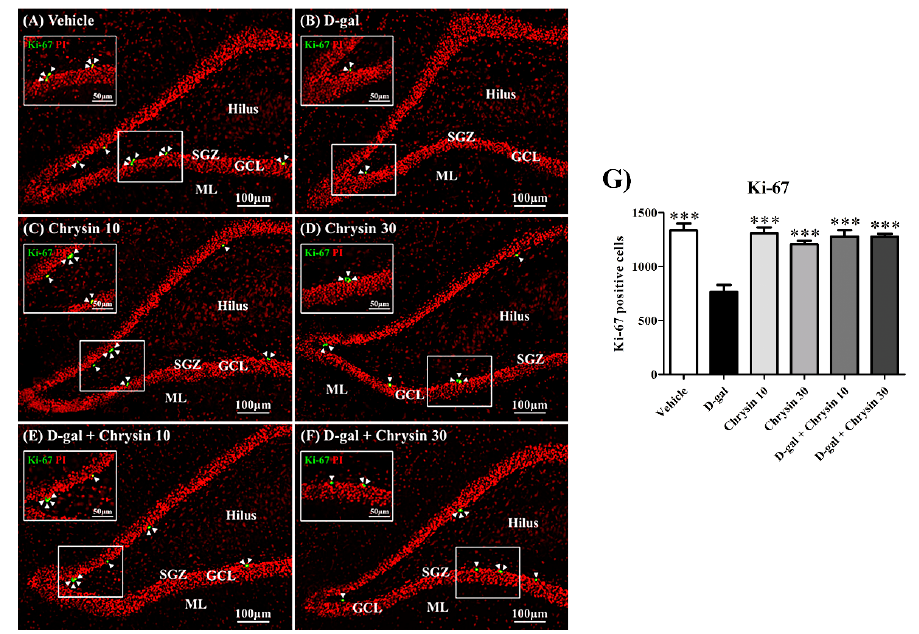
Figure 5. Immunofluorescence staining of all the experimental groups ( A – F ). Ki-67 positive cells (green) are indicated by arrowheads, and all nuclei were stained with propidium iodide (red). The vehicle, chrysin 10, chrysin 30, and D-gal + chrysin groups had significantly greater numbers of cells stained with Ki-67 than the D-gal group (*** p < 0.001, G ). SGZ: subgranular zone; GCL: granule cell layer; ML: molecular layer.